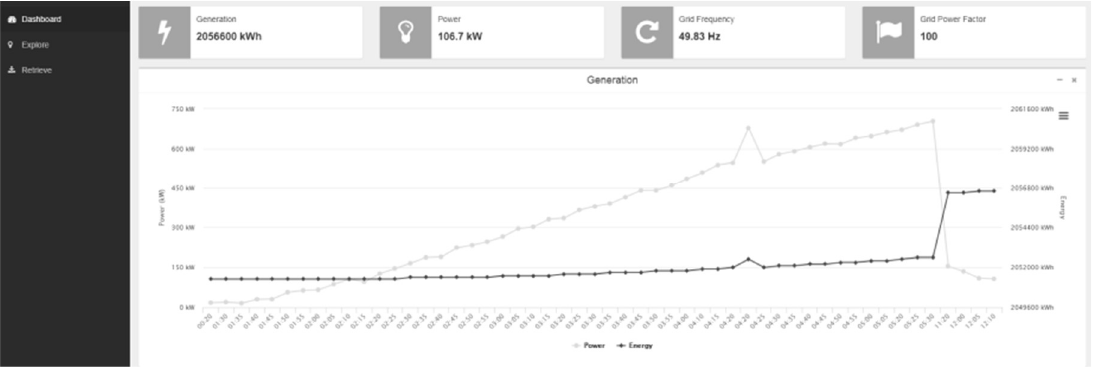
Figure 6. Screenshot of the User Interface.